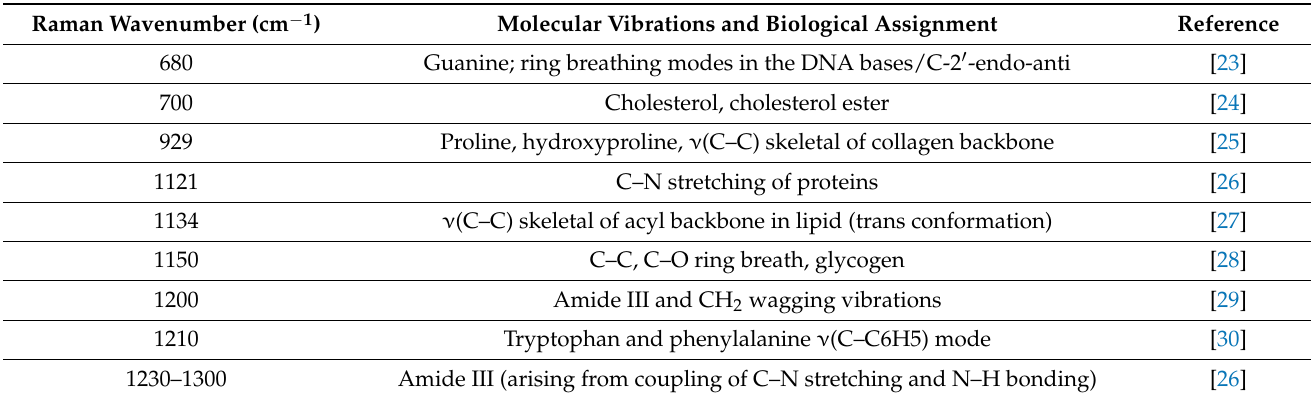
Table 1. Molecular vibrations and biological assignment of Raman wavenumbers of importance via LDA